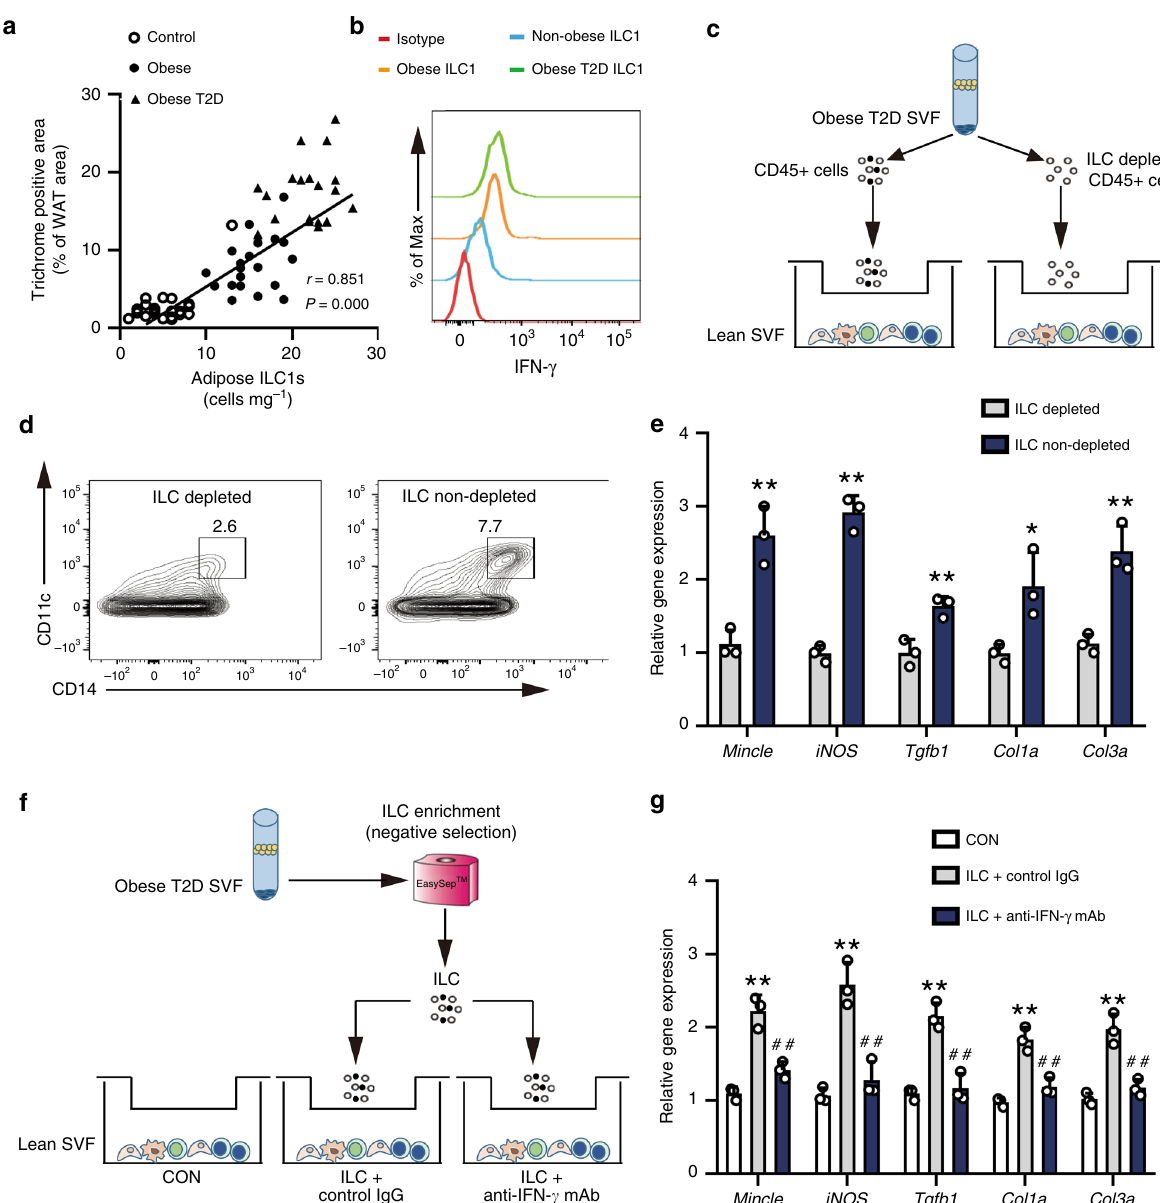
Fig. 2 Adipose ILC1s contribute to adipose tissue fi brogenesis in humans. a Association of adipose ILC1s with trichrome C staining area. b Representative histogram of IFN- γ in adipose ILC1s from control subjects, obese subjects, and obese T2D patients. The data are representative of three independent experiments. c – e SVFs isolated from control subjects were co-cultured with either CD45 + cells or ILCs-depleted CD45 + cells sorted from the SVFs of obese T2D patients; meanwhile, trehalose-6,6 ’ -dimycolate (5 μ g well − 1 ) and palmitate (200 μ M) were added in the lower chamber. Three days after co- culture, SVFs in the lower chamber were collected for further detection. c Illustration of the co-culture experiments. d Representative plots of CD11c + macrophages in SVFs of the lower chamber. e mRNA expression of Mincle , iNOS , and fi brosis-related genes ( Tgfb1 , Col1a , Col3a ) in SVFs of the lower chamber. * P < 0.05 vs. ILC depleted group; ** P < 0.01 vs. ILC depleted group (unpaired two-way Student ’ s t test). The data are representative of three independent experiments. f , g In another set of the co-culture experiment, 1 × 10 8 cells of the SVF from obese T2D patients were magnetically enriched for ILCs using negative immunomagnetic selection. Then, adipose ILCs were co-cultured with SVFs of control subjects (1 × 10 6 well − 1 ). Trehalose-6,6 ’ - dimycolate (5 μ g well − 1 ), palmitate (200 μ M), recombinant human IL-12 (20 ng ml − 1 ), and recombinant human IL-18 (20 ng ml − 1 ) were supplemented in the upper chamber, with neutralizing IFN- γ antibody (20 ng ml − 1 ) or IgG isotype control antibody (20 ng ml − 1 ) added in separate group. SVFs isolated from adipose tissue of control subjects were cultured alone and determined as control group. After co-culture for 72 h, SVFs in the lower chamber were collected for further detection. f Graphical illustration of the co-culture experiments. g mRNA expression of Mincle , iNOS , Tgfb1 , Col1a , and Col3a in SVFs of the lower chamber. ** P < 0.01 vs. control group; ## P < 0.01 vs. ILC + Control IgG group (two-way ANOVA tests followed by Bonferroni post hoc test). The data are representative of three independent experiments. Error bars indicate s.d. IFN interferon, ILC innate lymphoid cells